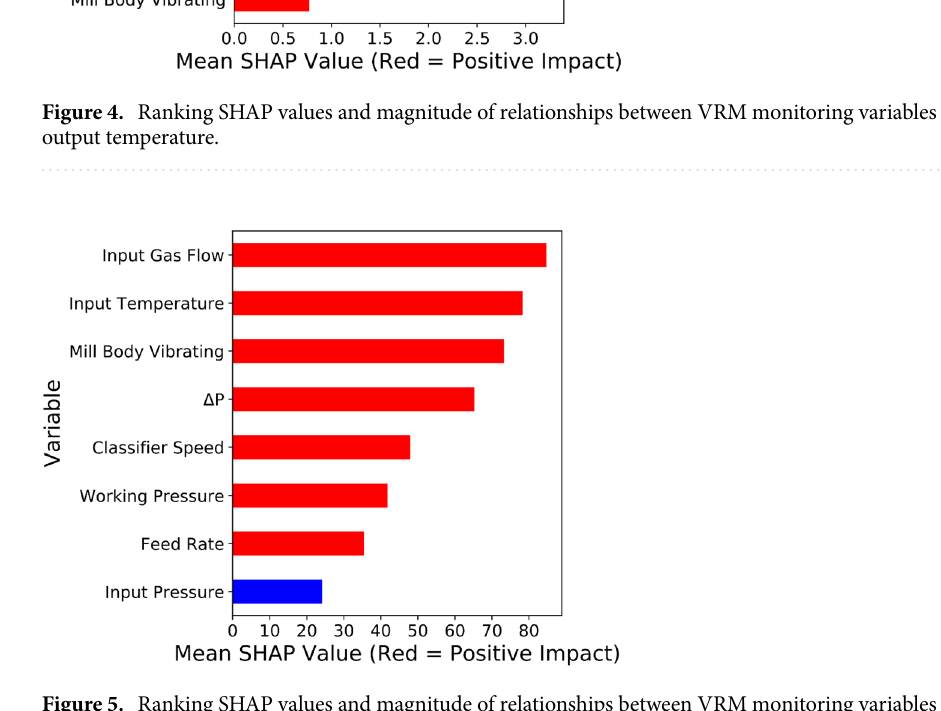
Figure 5. Ranking SHAP values and magnitude of relationships between VRM monitoring variables and motor